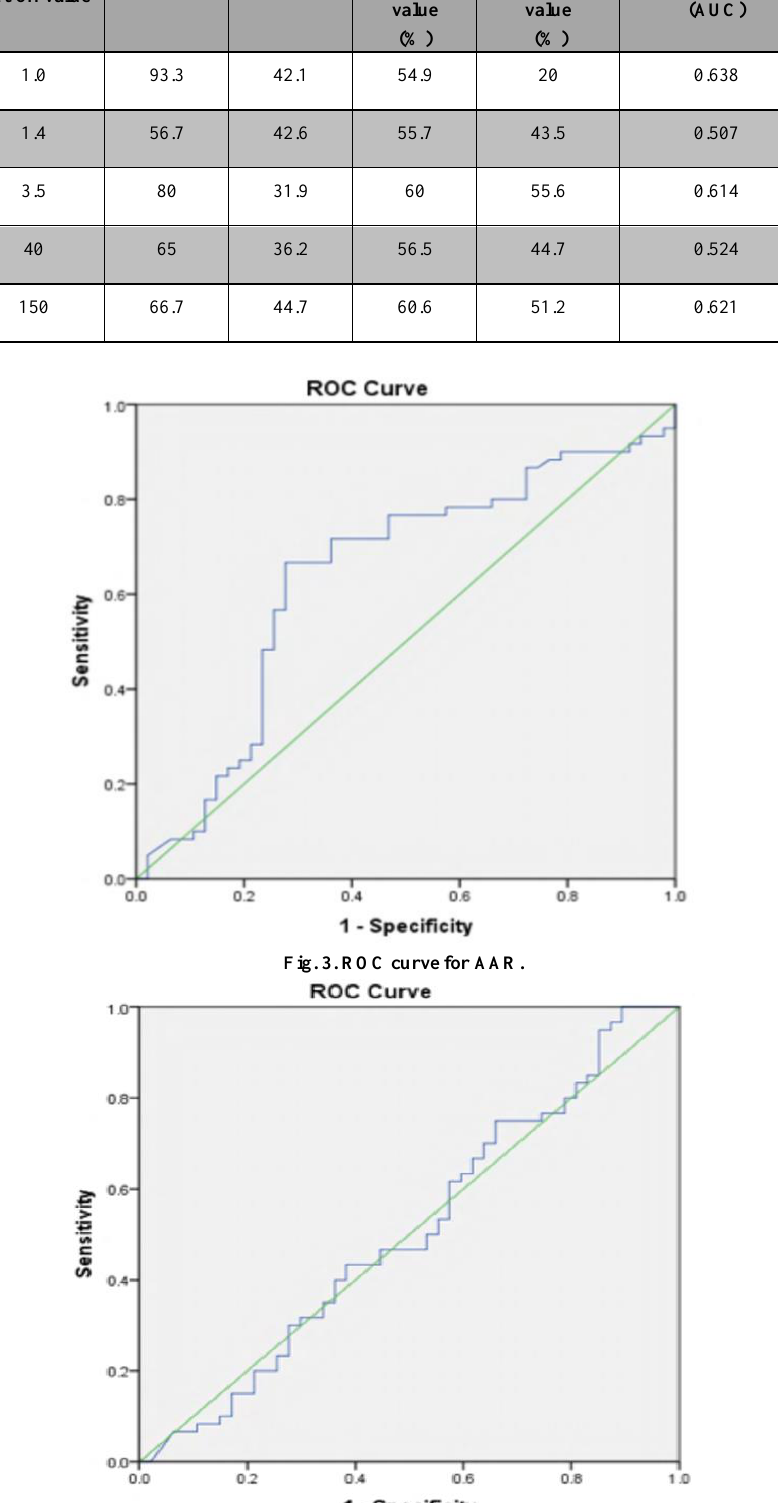
Fig. 4. ROC curve for